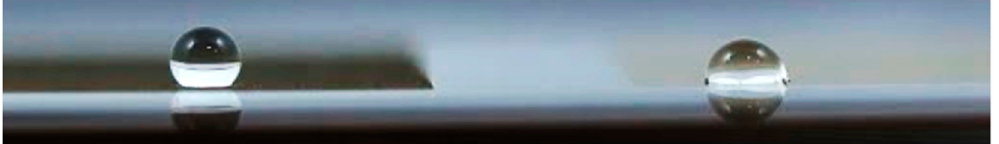
Figure 9. A processed metal surface with <2% reflectance shows a larger contact angle (left) than the unprocessed one with about 12% reflectance